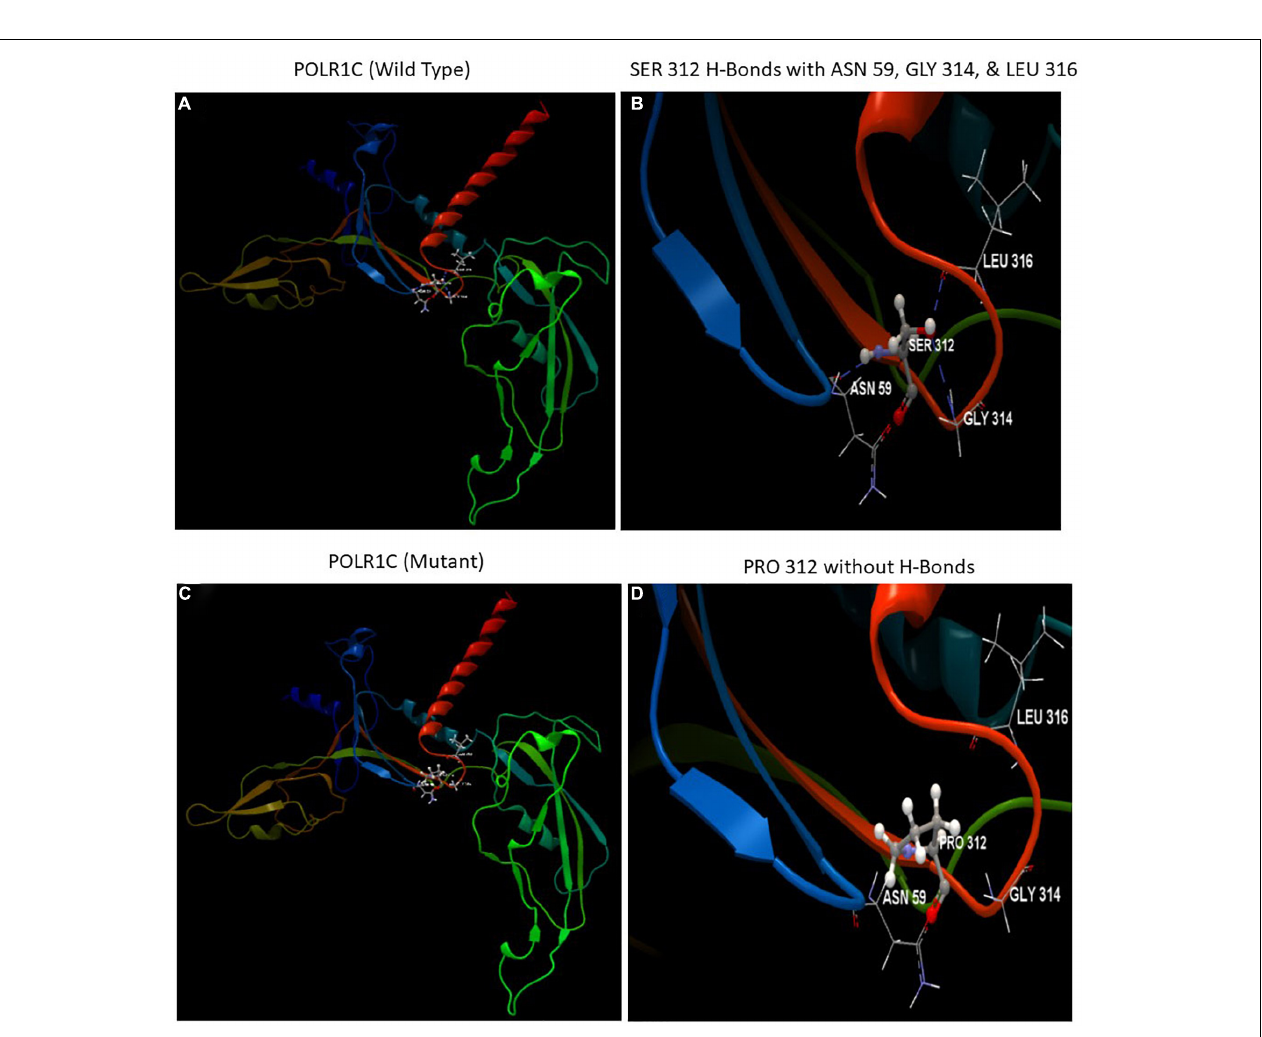
Frontiers in Pediatrics |